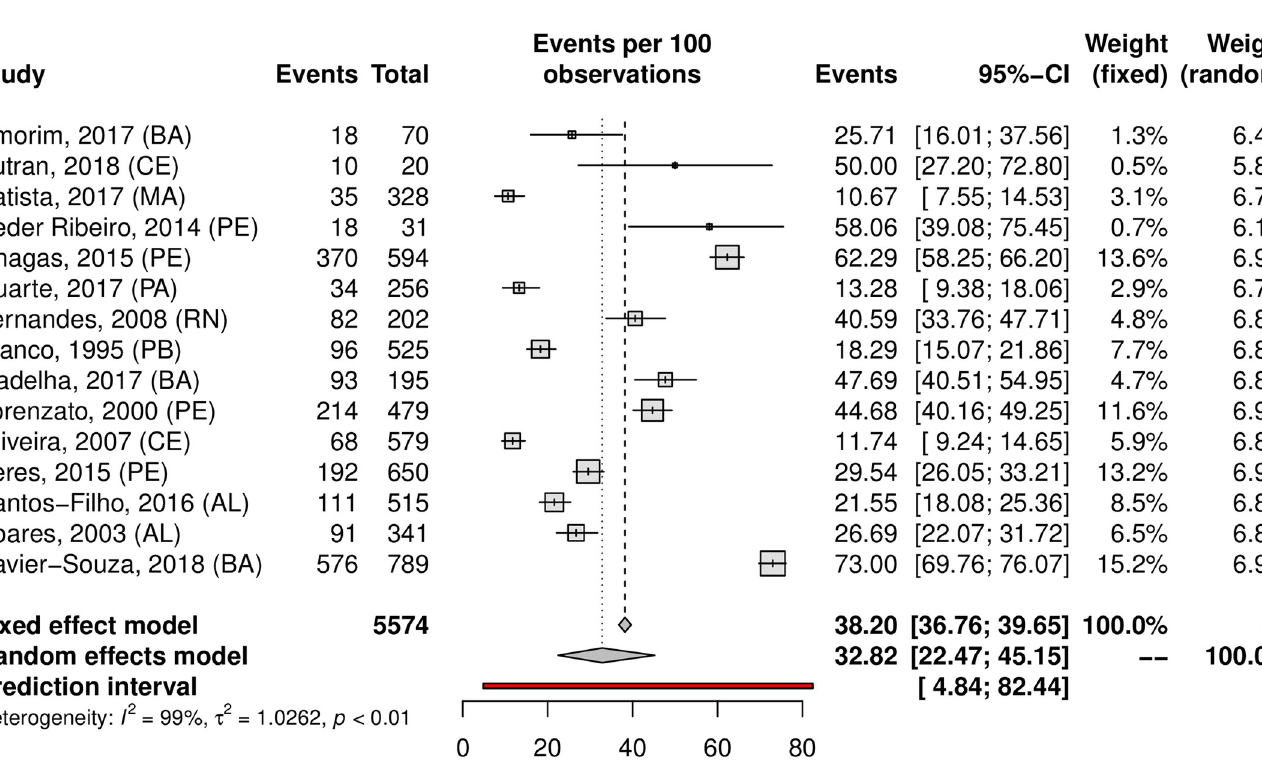
Fig 10. Prevalence of cervical HPV in the Northeast region of Brazil. Forest plot of a metanalysis of studies reporting prevalence of cervical infection by HPV in the Northeast region of Brazil.